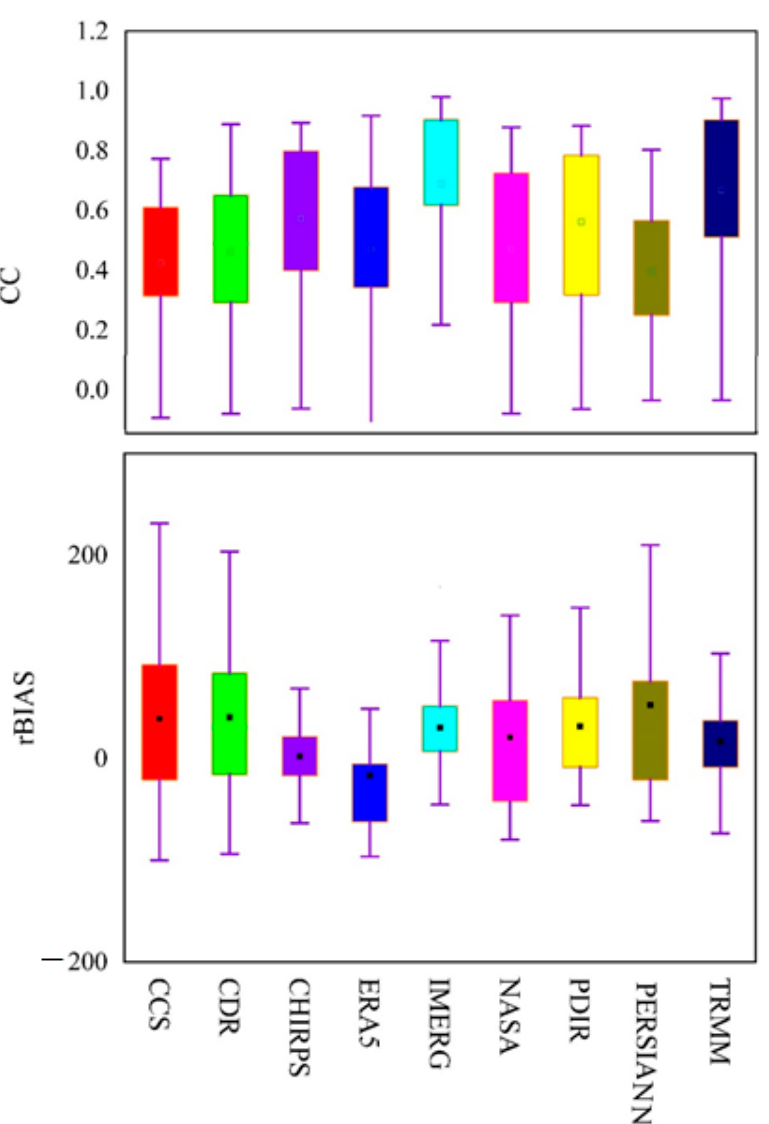
Figure 7. The box plots of evaluation indices (CC and rBias) for monthly estimates of SPPs and reanalysis products in Pakistan. reanalysis products in